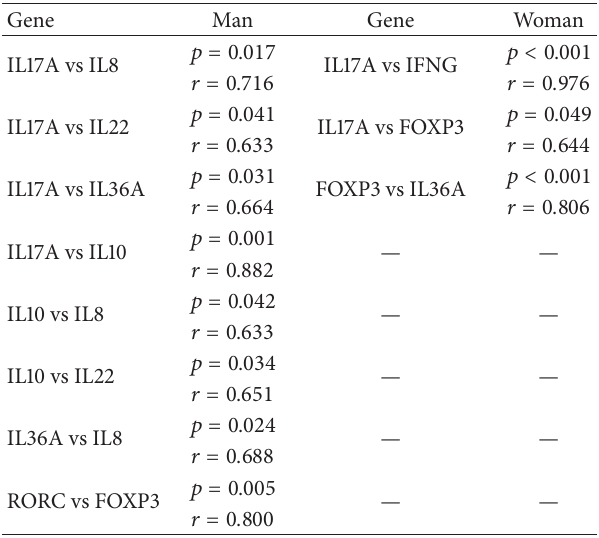
Table 3: Correlation coefficients and 𝑝 values by gender a .